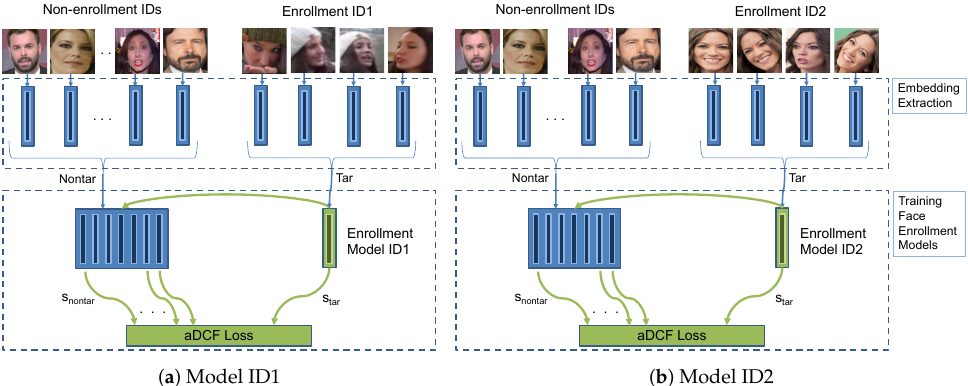
Figure 3. ( a ) Left: Example of Embedding Extraction and Training Enrollment Model ID1, where the dashed line indicates the two steps of the process. ( b ) Right: Example of Embedding Extraction and Training Enrollment Model ID2, where the dashed line indicates the two steps of the